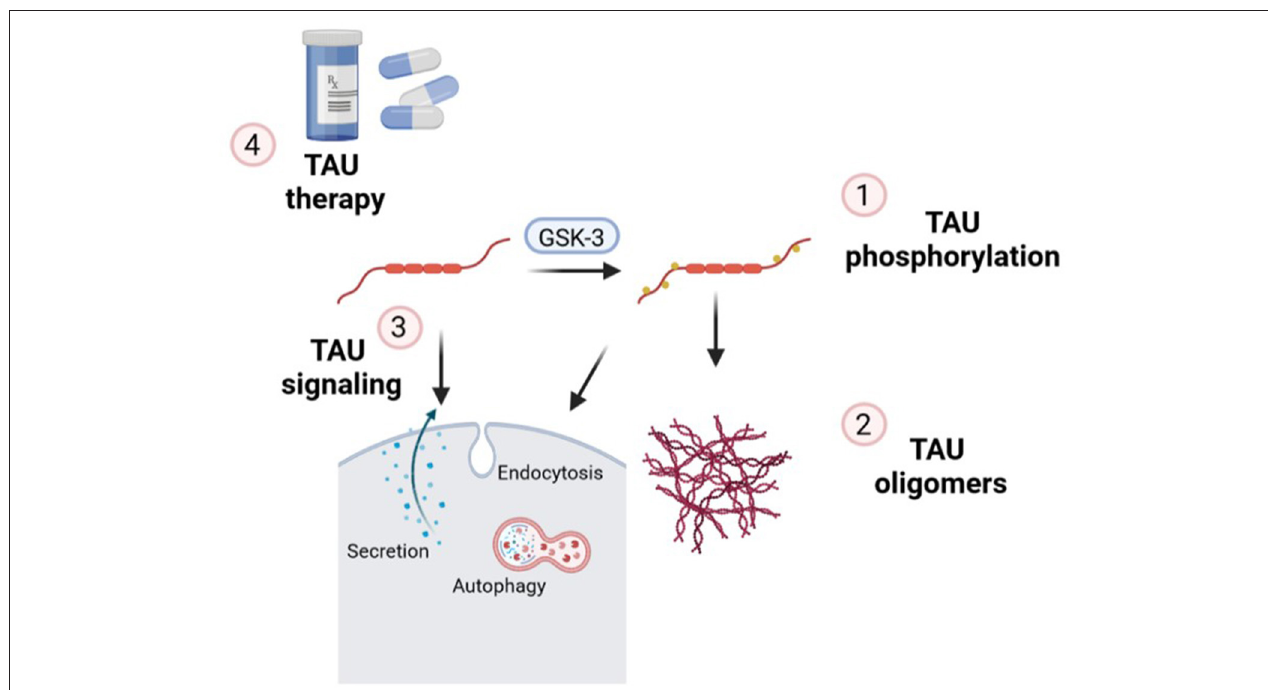
FIGURE 1 | Essential points of the mechanisms of action of TAU in which new findings have been made on this topic and contextualized in this Editorial: (1) TAU phosphorylation; (2) formation of TAU oligomers; (3) implications of endocytosis, secretion, and autophagy in TAU signaling and (4) new insights related to TAU therapeutic